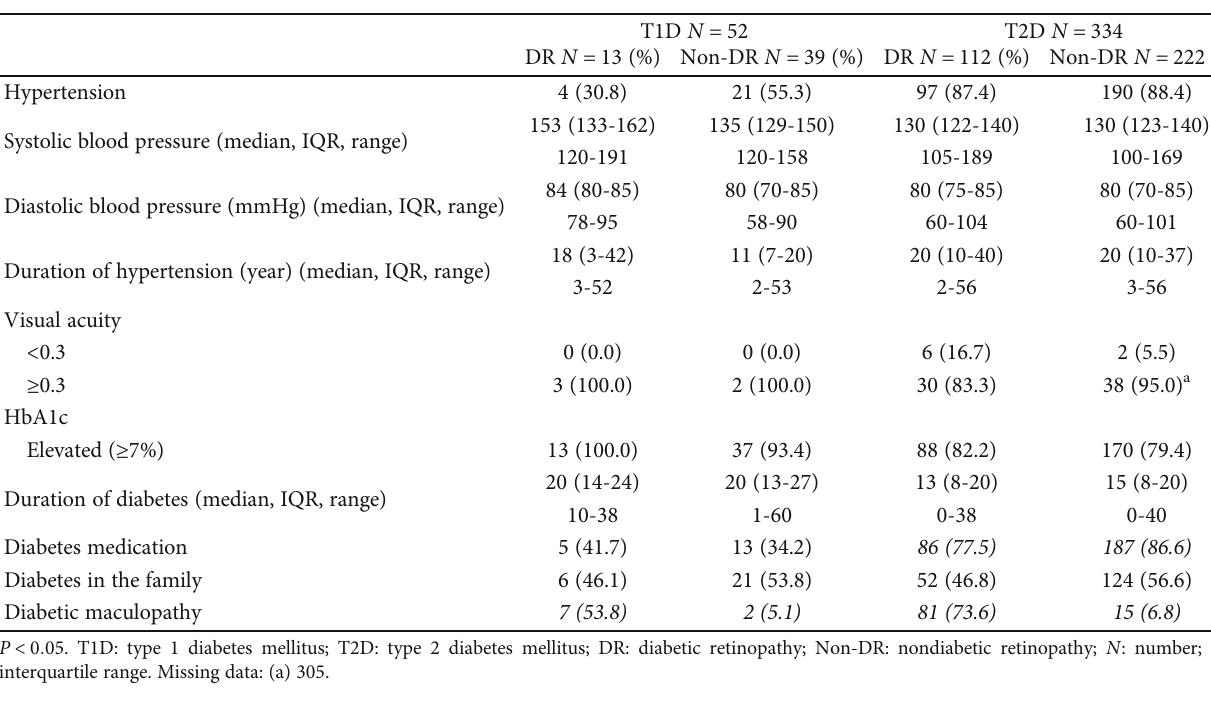
Table 4: Characteristics of the health status of the study participants.